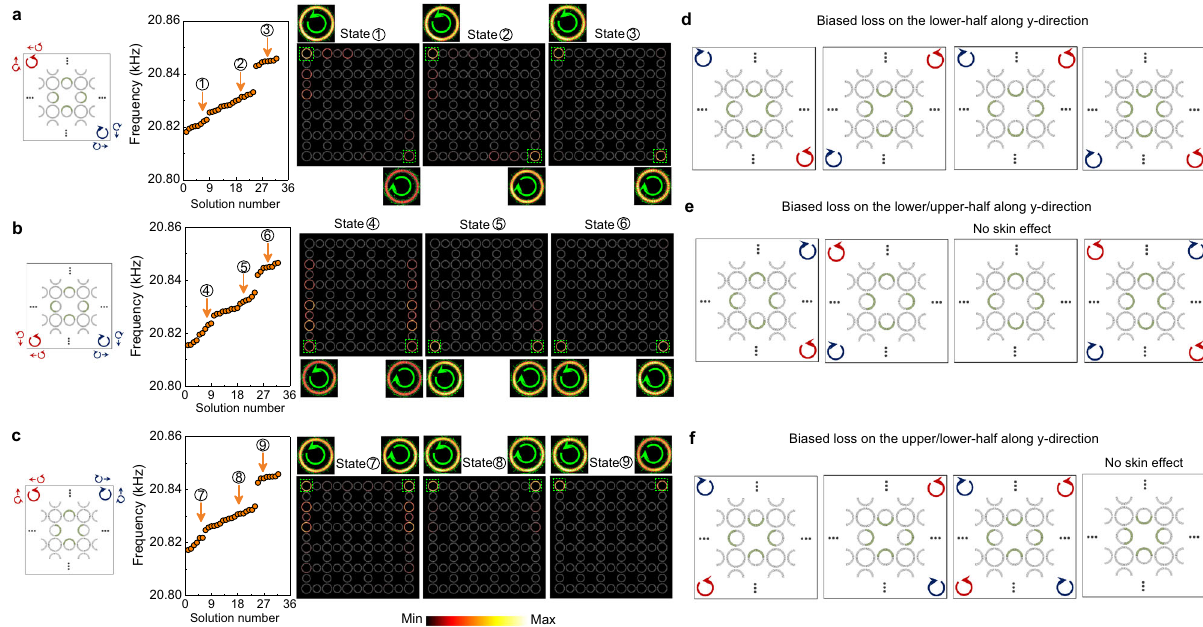
Fig. 4 Con fi gurable non-Hermitian skin effects. a – c Calculated eigen-spectra for three box-shaped SCs with different loss con fi gurations (as indicated by the green regions in each unit-cell). Associated with different loss con fi gurations, the higher-order non-Hermitian skin effect is manifested at different corners with different spin-polarizations (as illustrated by the blue and red thick arrows in the box and numerically demonstrated by the acoustic wavefunctions). d – f Other schemes to obtain various non-Hermitian skin effects by engineering loss con fi